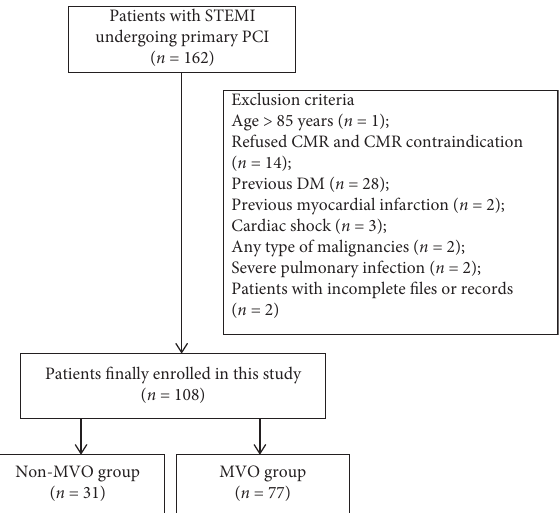
Figure 1: Flowchart of the study selection process. STEMI, ST- segment elevation myocardial infarction; PCI, percutaneous in- tervention; CMR, cardiac magnetic resonance; DM, diabetes mellitus; MVO, microvascular